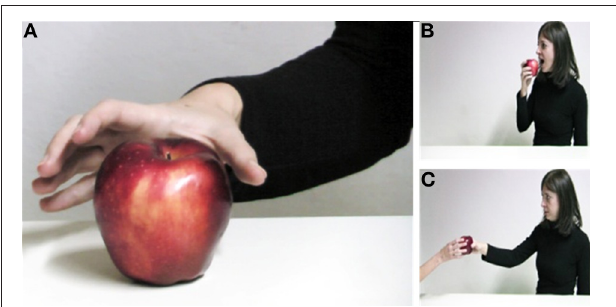
FIGURE 1 | Intention from movement understanding. The same action sequence—reaching toward and grasping an apple (A) —can be performed with different intents: (B) eat the apple, or (C) hand the apple to another person. Is it possible to understand the intention of a person grasping the apple by simply observing her